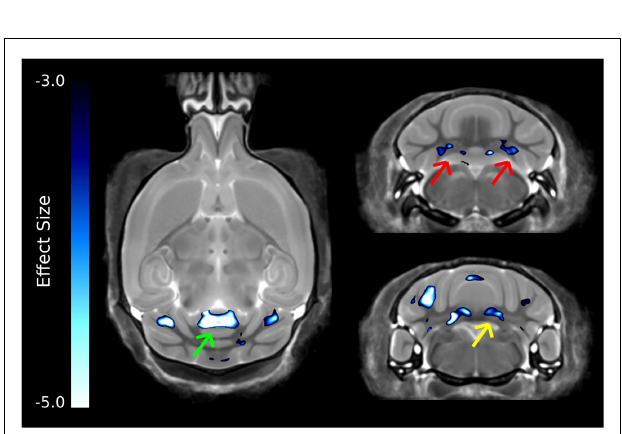
FIGURE 6 |The most highly significant changes in the cerebellum. These differences have effect sizes smaller (i.e., more significant) than − 3.0. Highlighted in this figure are strong changes in the anterior cerebellar vermis (green arrow), fastigial nucleus (red arrows), and nucleus interpositus (yellow